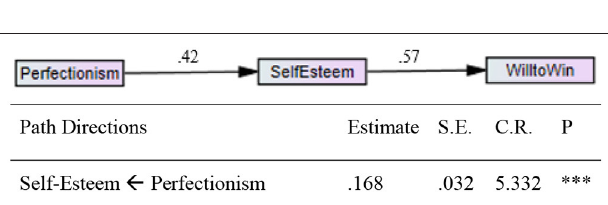
FIGURE 3 | Path analysis of the latent construct using data obtained from female athletes.